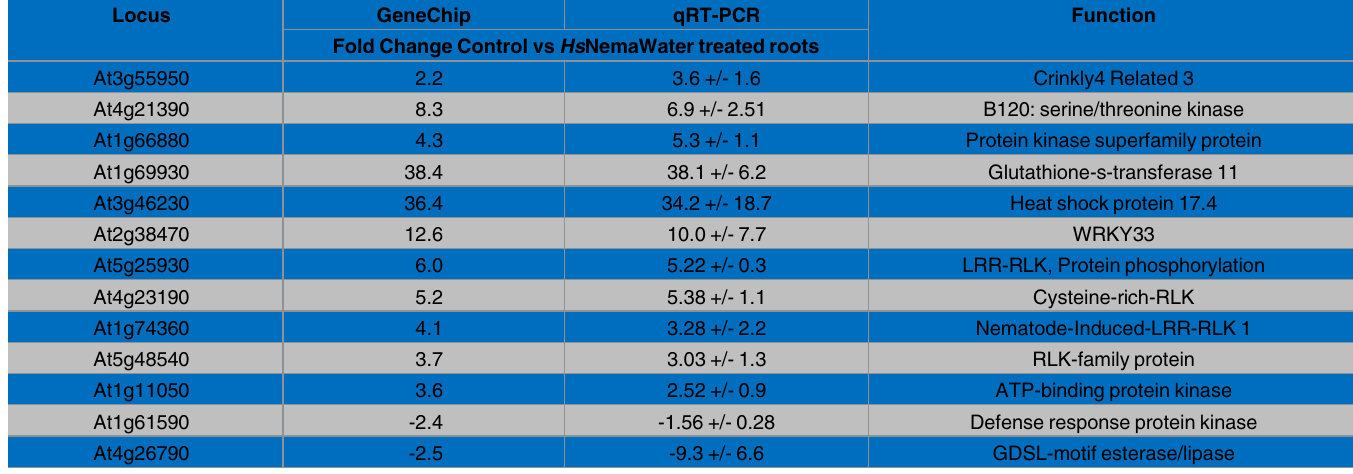
Table 1. Validation of changes in gene expression upon Hs NemaWater treatment via qRT-PCR. The values represent relative fold changein response to NemaWater treatment as comparedwith control roots. 18S was used as housekeeping gene to normalize the data. All values are means of three biological replicates+/- SD.